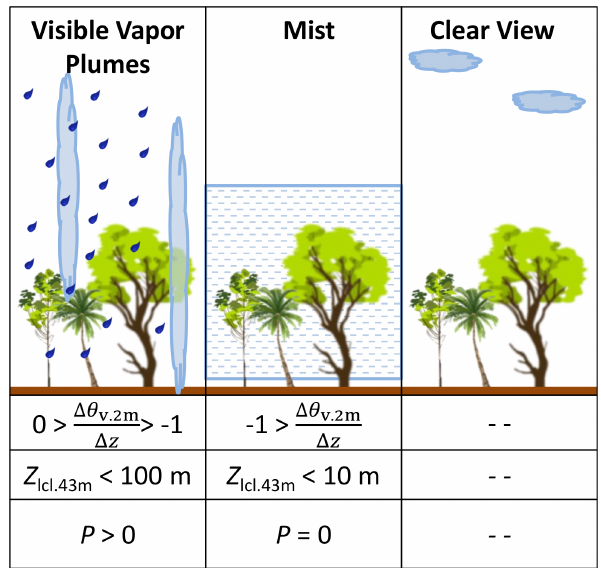
Figure 4. Simplification diagram describing the required conditions to form visible vapor plumes in a tropical wet forest and the differ- ences between mist and clear view